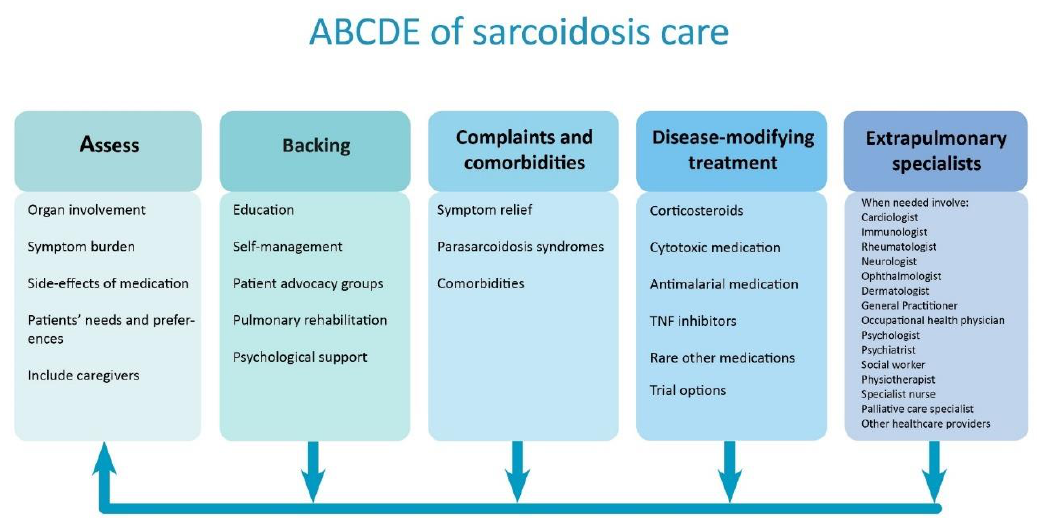
Figure 2. Structured approach to comprehensive care in sarcoidosis. The arrows show that individual patient’s symptoms, needs, and treatment should regularly be reassessed. TNF = tumor necrosis factor. Overall, sarcoidosis patients have an impaired QoL compared with the healthy population